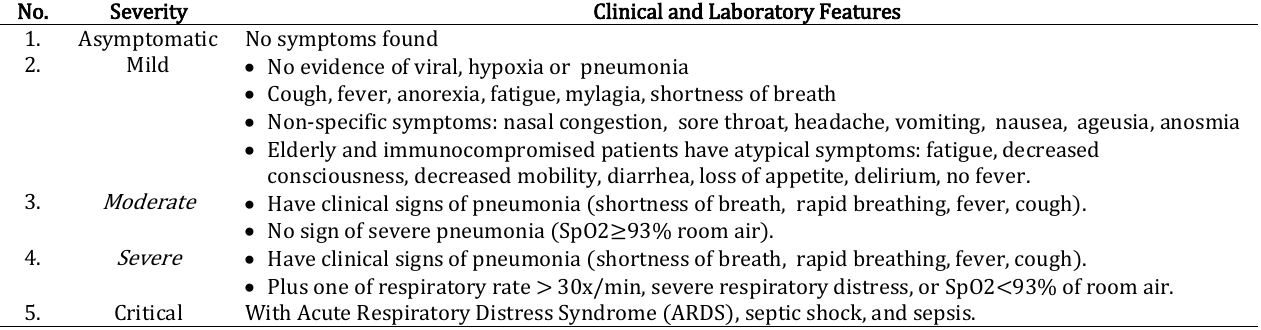
Table 1. Severity Criteria of